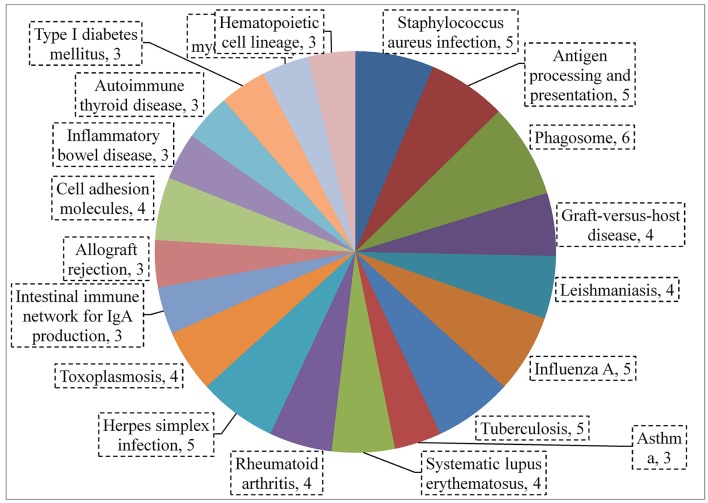
KEGG pathway analysis using string showing significantly (p < 0.05) upregulated genes (by ≥1.5-fold) after multi-species colonization of the rat middle ear mucosa.